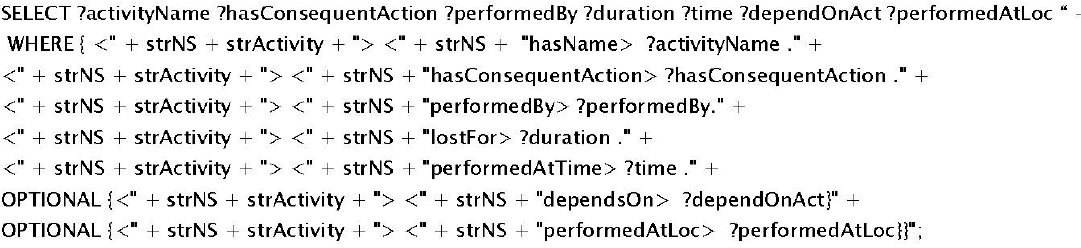
Figure 8. SPARQL query to extract information for match making.